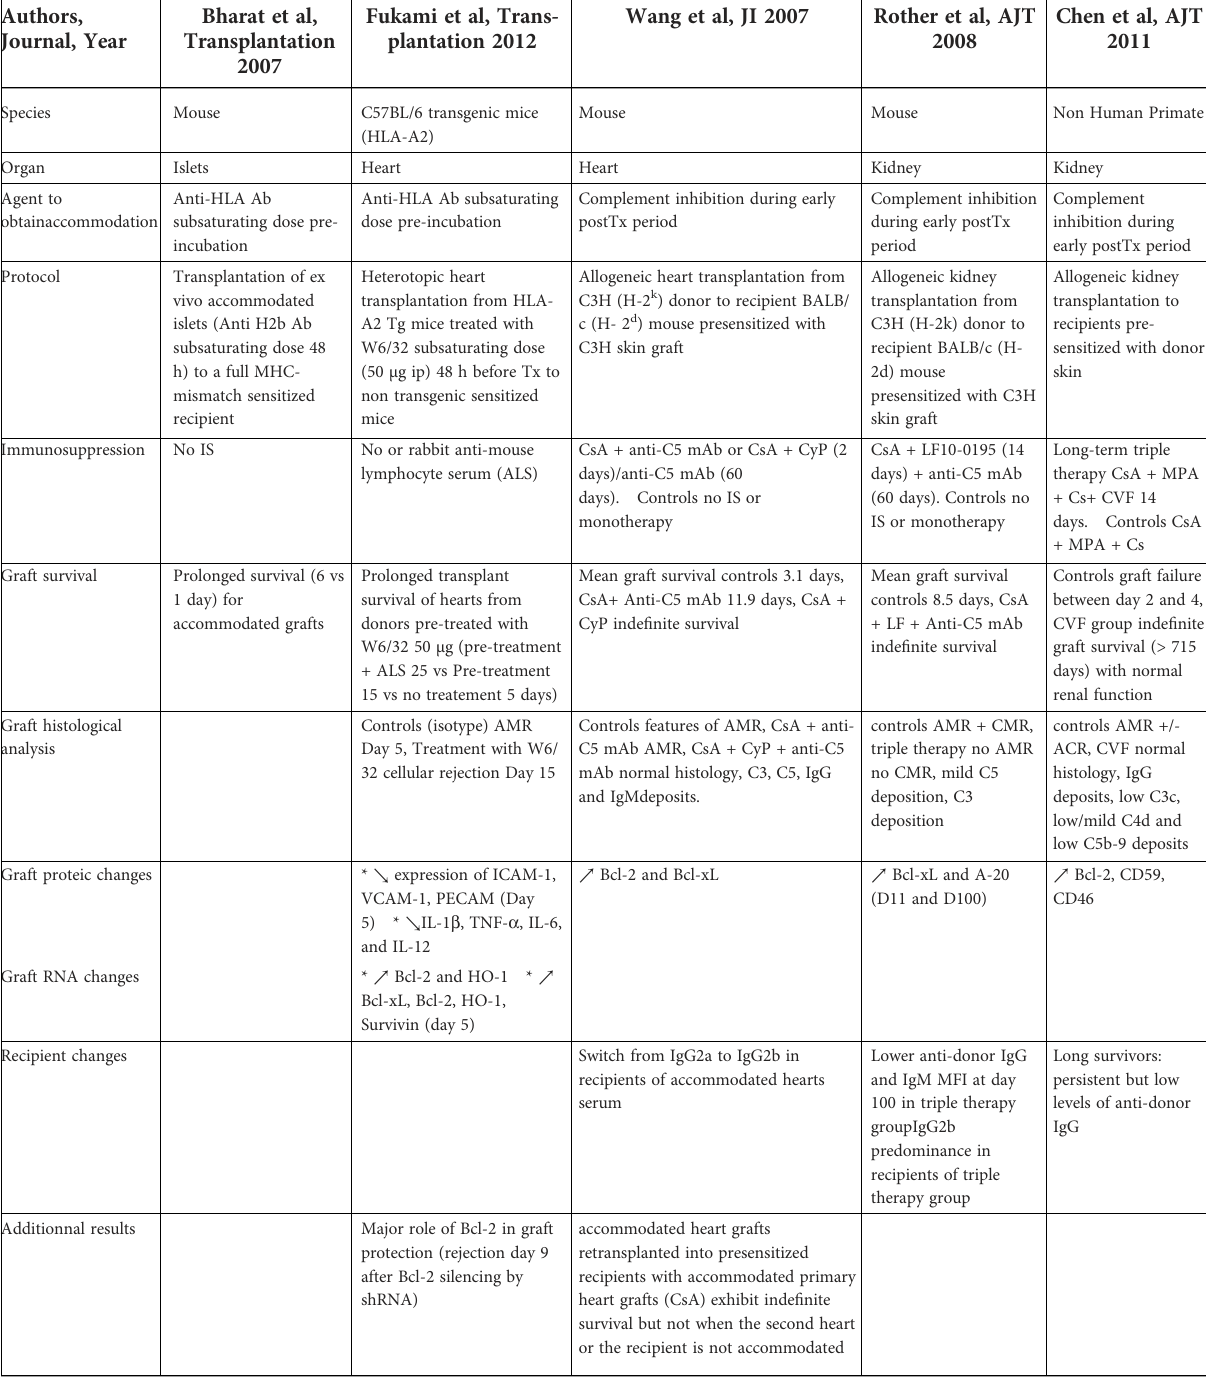
TABLE 2 In vivo induction of accommodation in allogeinic